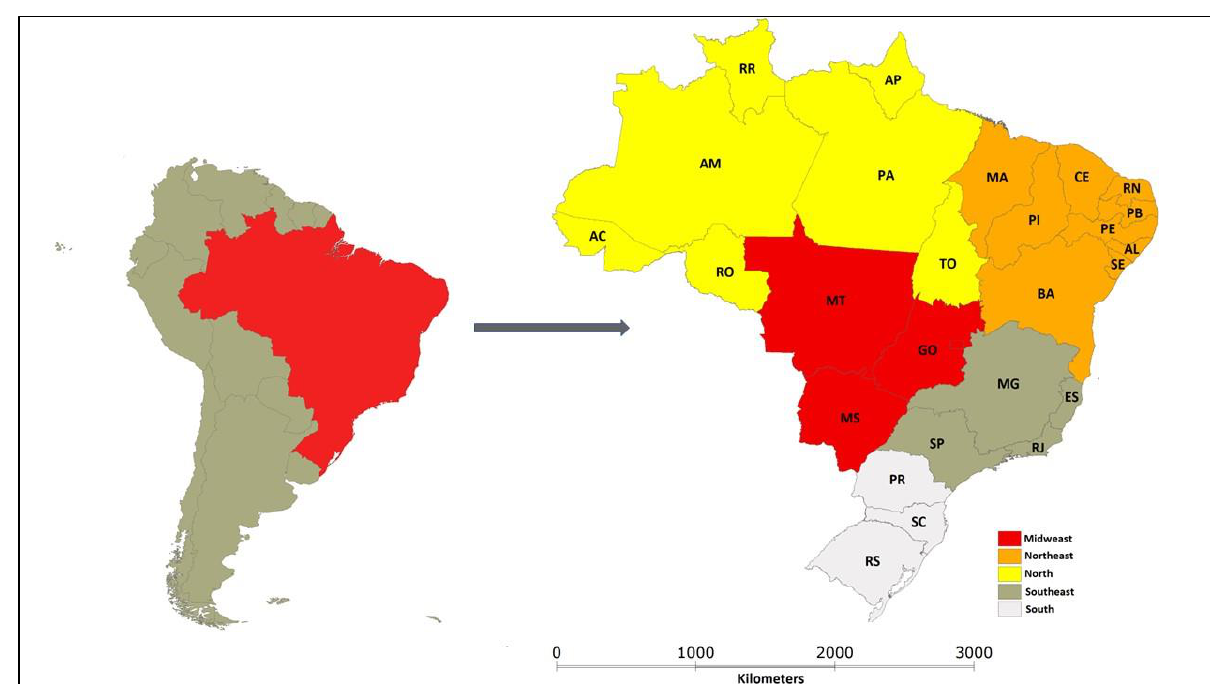
Figure 1. Maps showing the different regions and states in Brazil. Brazil is divided into the following states: Acre (AC), Alagoas (AL), Amapá (AP), Amazonas (AM), Bahia (BA), Cerá (CE), Espírito Santo (ES), Goiás (GO), Maranhão (MA), Mato Grosso (MT), Mato Grosso do Sul (MS), Minas Gerais (MG), Pará (PA), Paraíba (PB), Paraná (PR), Pernambuco (PE), Piauí (PI), Rio de Janeiro (RJ), Rio Grande do Norte (RN), Rio Grande do Sul (RS), Rondônia (RO), Roraima (RR), Santa Catarina (SC), São Paulo (SP), Sergipe (SE) and Tocantins (TO), which are grouped into five Brazilian regions (Midwest, Northeast, North, Southeast, and South). The maps were created in Terraview ® Software (INPE, São José dos Campos, Brazil, v.4.2.0)